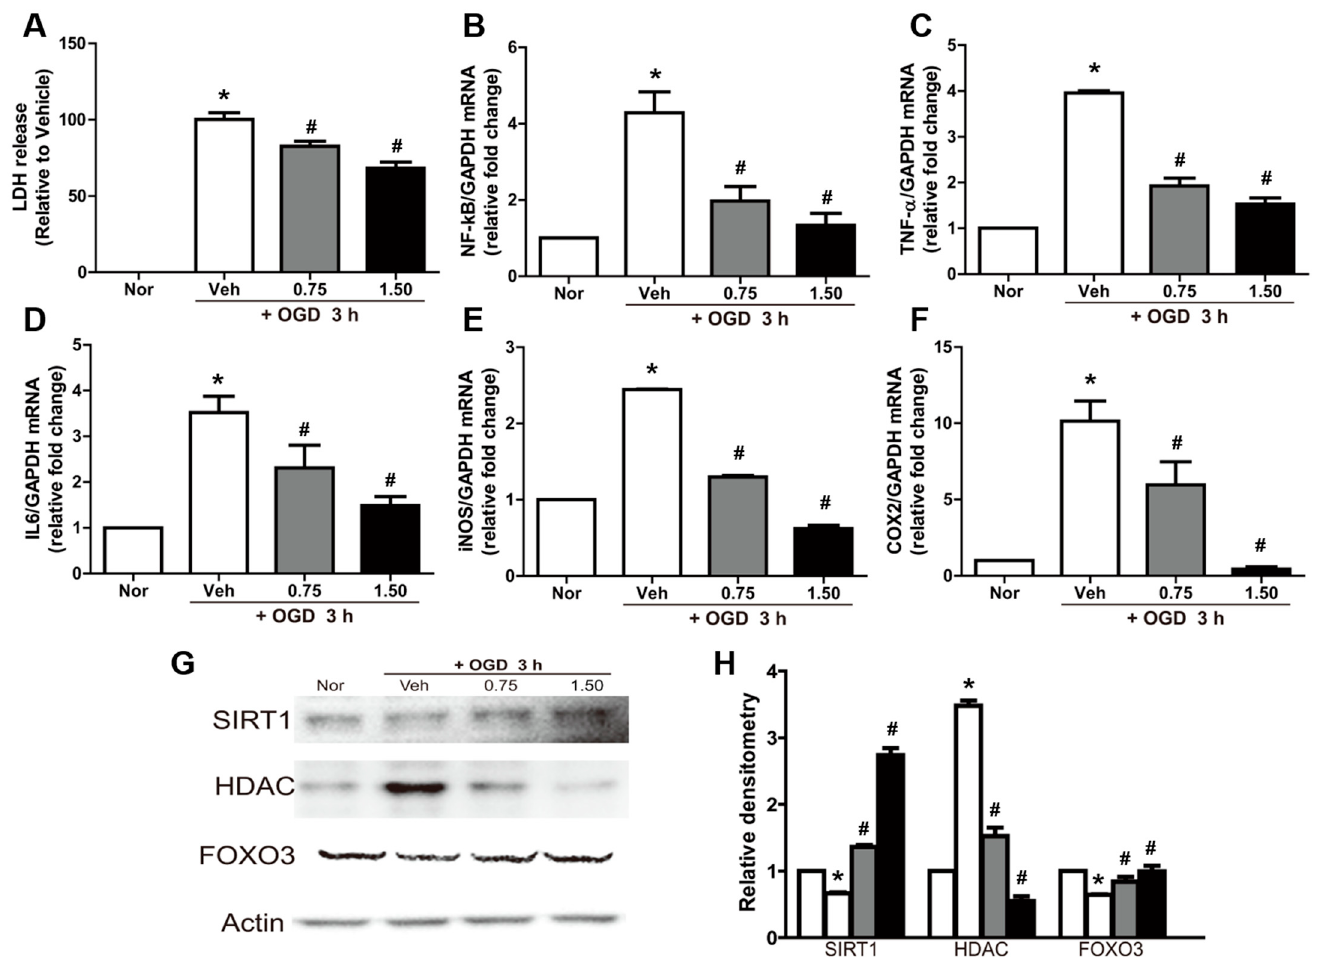
Figure 2. Neuroprotective and anti-inflammatory effects of exosomes in N2A cells subjected to oxygen–glucose deprivation (OGD). (A) Neuroprotective effects of exosomes under 3 h OGD exposure in the lactate dehydrogenase (LDH) assay; (B–F) real-time PCR analysis of mRNA of nuclear factor (NF)- κ B (B), tumor necrosis factor (TNF)- α (C), interleukin (IL)-6 (D), inducible nitric oxide synthase (iNOS) (E), and cyclooxygenase 2 (COX2) (F) normalized to glyceraldehyde-3-phosphate dehydrogenase (GAPDH); (G,H) Western blot analysis of sirutin 1 (SIRT1), histone deacetylase (HDAC), and forkhead box O-3 (FOXO3) showing representative bands (G) and band densities normalized to actin (H). Densitometric analysis of the Western blot was performed using ImageJ. n = 3 per treatment group. * Significantly different from normal control ( p < 0.05). # Significantly different from vehicle control ( p < 0.05).